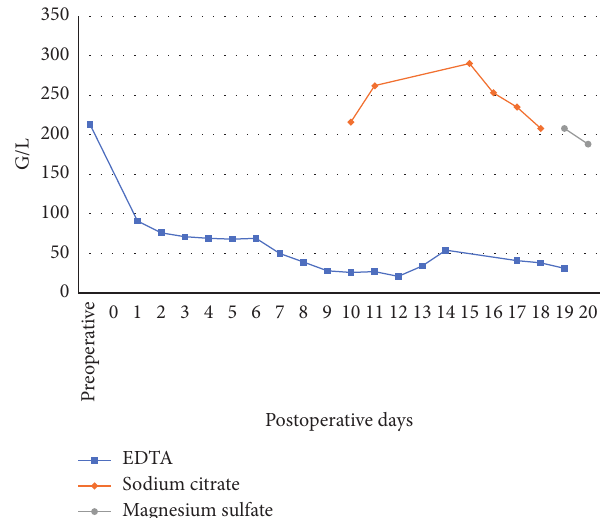
Figure 1: Postoperative platelet count with different blood collection tubes (EDTA, Sodium Citrate, Magensium sulfate) as shown.